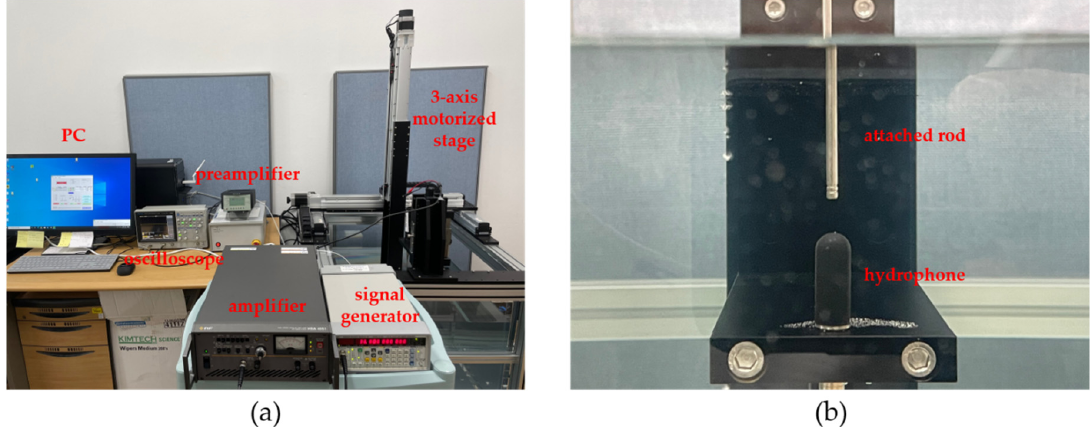
Figure 4. Pressure calibration system: ( a ) overall set-up; ( b ) hydrophone, and titanium rod.